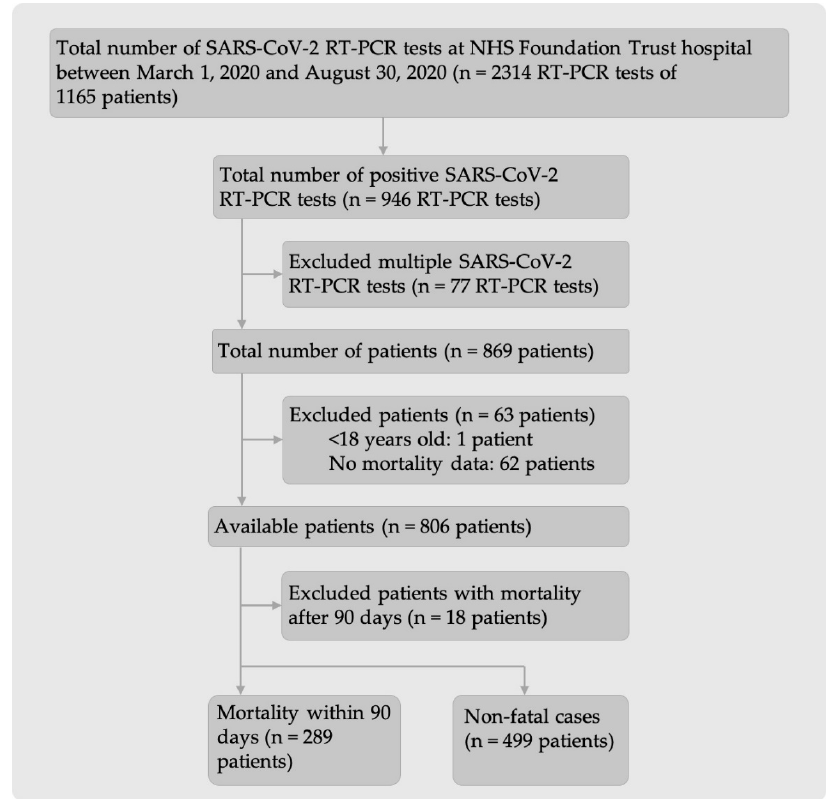
Figure 1. Flow diagram of inclusion and exclusion criteria for patients admitted to hospital with either suspected SARS-CoV-2 infection or before the COVID-19 pandemic. The timeframe of mortality was determined by the mean time span ± 2 standard deviation (SD) between the first positive SARS-CoV-2 RT-PCR test up to the day of death (21.9 days ± 34.4 days; Figure 2). Deaths occurring after 90 days were excluded from the subsequent analysis.